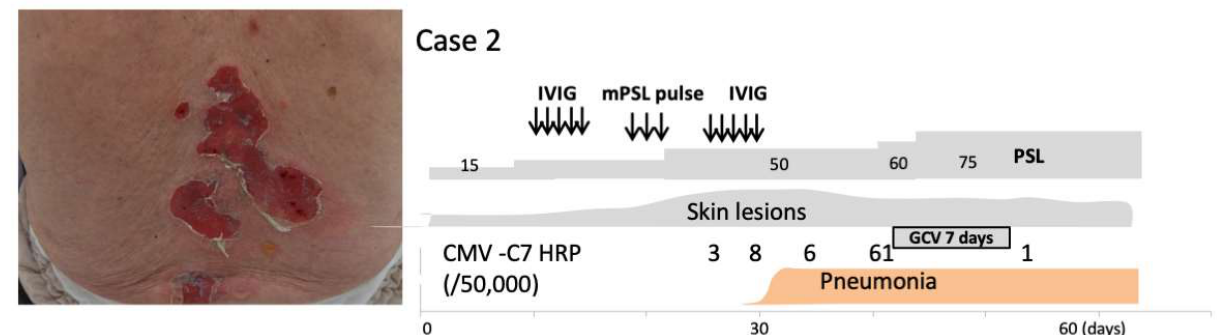
Figure 2. Case 2: Erosions due to pemphigus and its clinical course. CMV antigenemia developed following steroid pulse therapy, resulting in pneumonia.